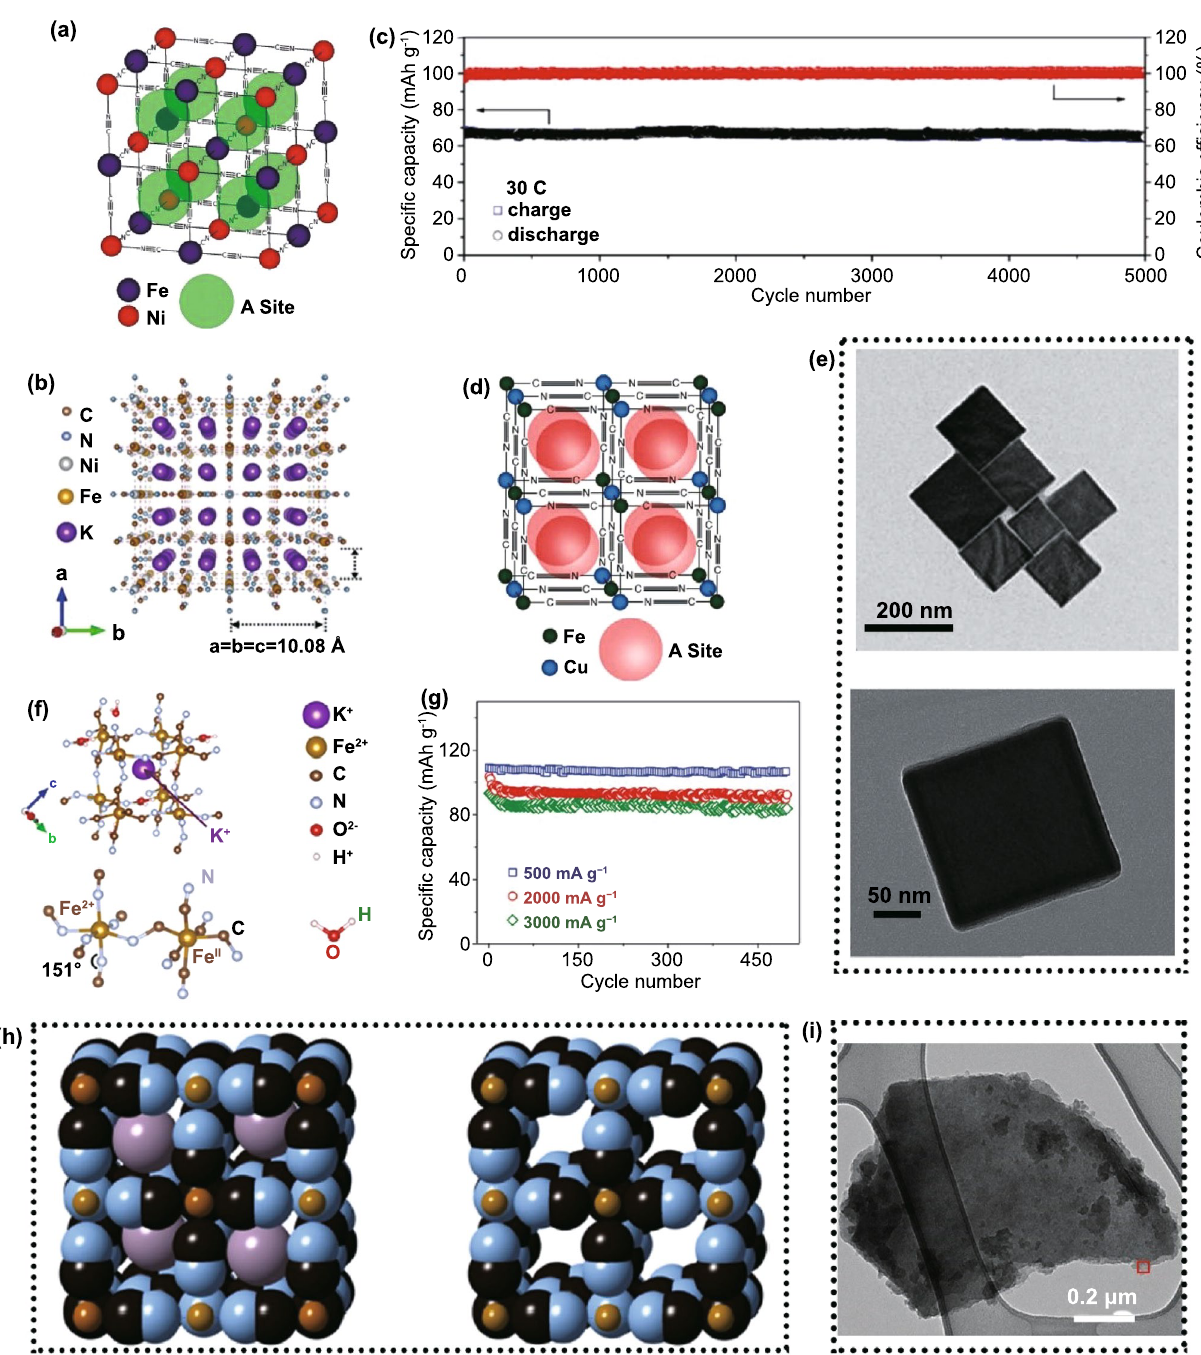
Fig. 9 a Face-centered cubic structure of NiFe-PBA (K 0.6 Ni 1.2 Fe(CN) 6 ·3.6H 2 O). Reproduced with permission from Ref. [43]. Copyright 2011, American Chemical Society. b General view of the face-centered cubic crystal structure of K 2 NiFe(CN) 6 ·1.2H 2 O. c Long-term cycling performance at 30 C of K 2 NiFe(CN) 6 ·1.2H 2 O. Reproduced with permission from Ref. [80]. Copyright 2018, Wiley–VCH. d Face-centered cubic structure of K 0.9 Cu 1.3 Fe(CN) 6 . Reproduced with permission from Ref. [74]. Copyright 2012, Electrochemical Society. e TEM image of K 2 Fe II [Fe II (CN)] 6 ·2H 2 O nanocubes. f Refined crystal structure of FeFe-PBA. g Long cycle performance of K 2 Fe II [Fe II (CN)] 6 ·2H 2 O nanocubes at different current density. Reproduced with permission from Ref. [7]. Copyright 2017, Wiley–VCH. h Crystal lattice unit cell of Prussian blue (left, KFe III Fe II (CN) 6 ) and crystal lattice unit cell of Prussian green (right, Fe III Fe III (CN) 6 ) (The black, blue, purple and brown balls represent C, N, K and Fe atoms, respectively). Reproduced with permission from Ref. [112]. Copyright 2015, Elsevier. i TEM image showing a MoS 2 flake uniformly decorated by Prussian blue nanoparticles to form K 0.47 Fe 4III [Fe II (CN) 6 ] 3.14 @(MoSO 1.7 ) 0.44 ·18H 2 O. Reproduced with permission from Ref. [113]. Copyright 2018,